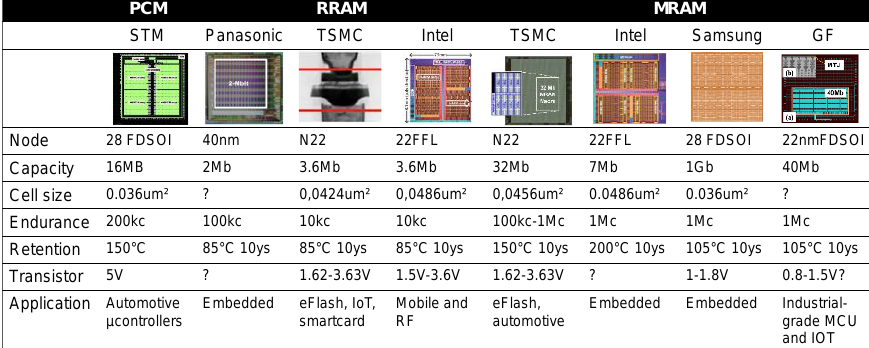
Figure 7. Table summarizing the emerging memory macros for embedded